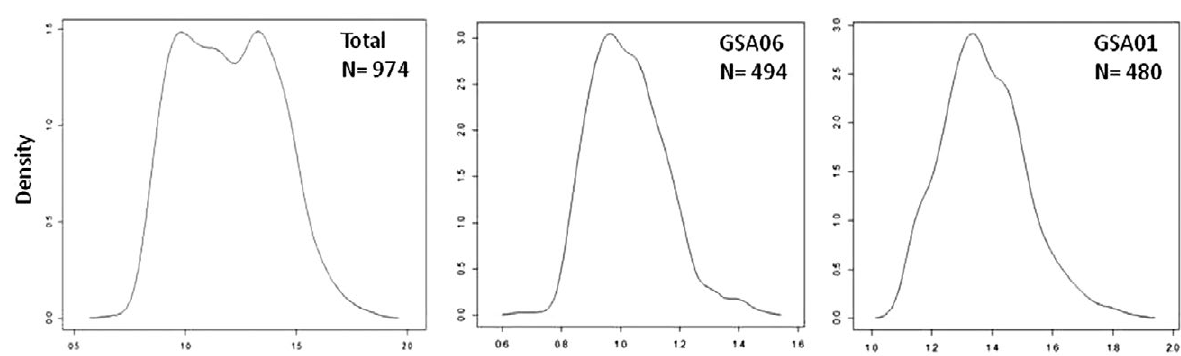
Fig. 5. – First otolith radio (R1) density functions, including the number of measured individual (N), both total and by GSA.